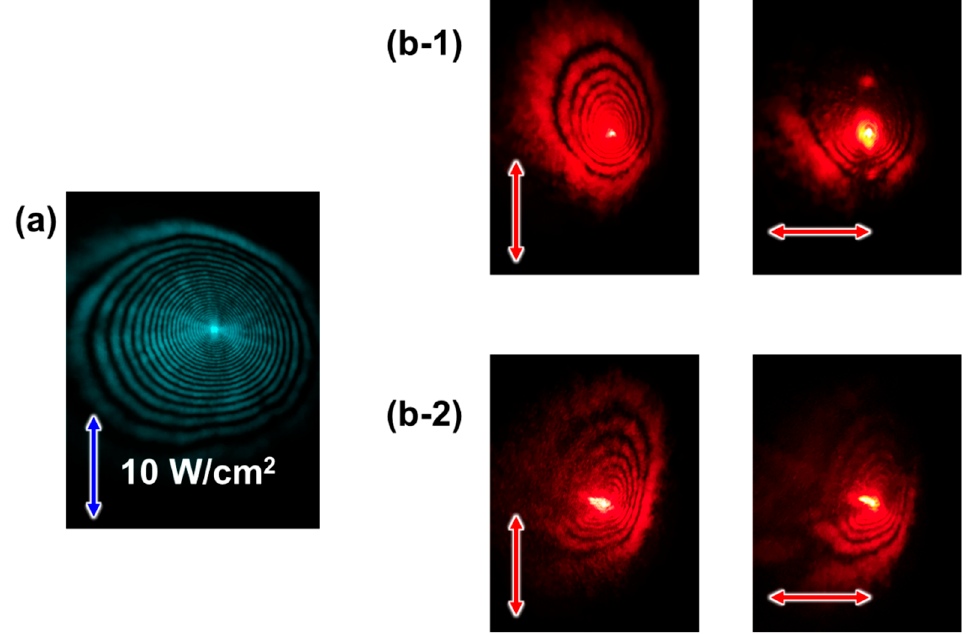
Figure 9. Photoinduced molecular reorientation by irradiating with a polarized laser beam. ( a ) Po- larized laser beam irradiated to the sample at 10 W/cm 2 , resulting in concentric diffraction rings. After 10 min of irradiation, the blue laser beam was removed and a red probe beam was used instead. Diffraction ring patterns of the red laser beam before ( b-1 ) and after ( b-2 ) photopolymerization. The blue and red arrows represent the polarization direction of the blue and red laser beams, respectively.